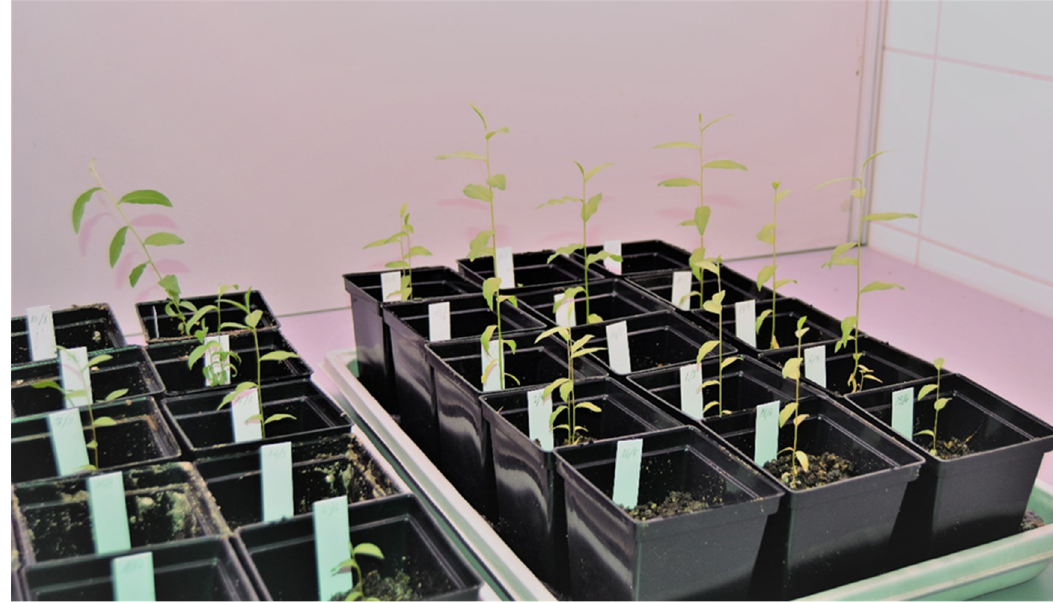
Figure 3. Plants obtained after six weeks of acclimatization after transplanting into P9 pots.